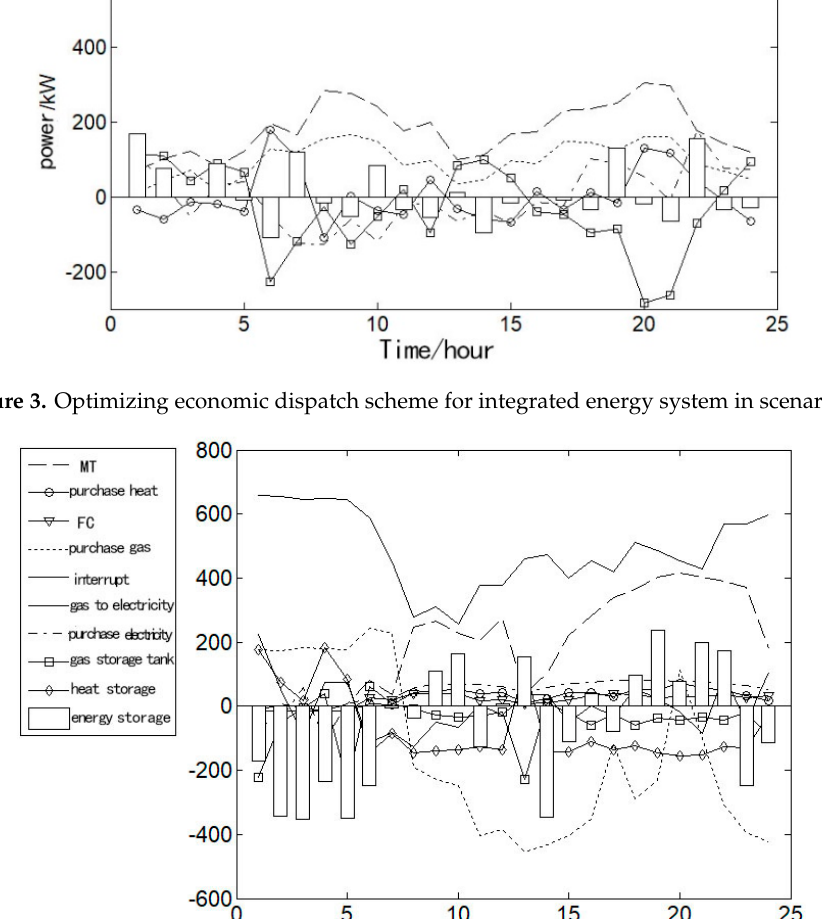
Figure 3. Optimizing economic dispatch scheme for integrated energy system in scenario 1.